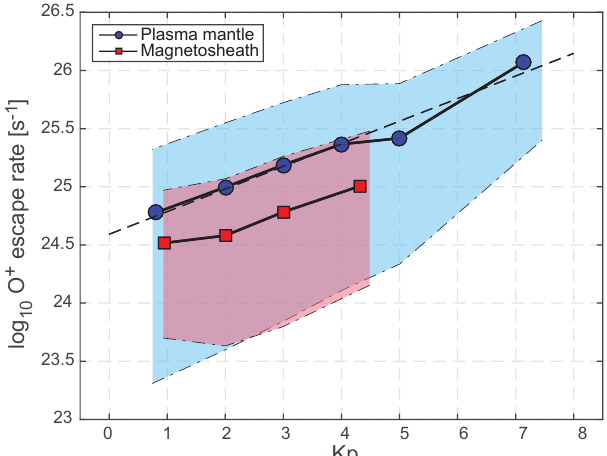
Figure 7. The average O + escape rates for the plasma mantle (solid blue line and circles) and the dayside magnetosheath (solid red line and squares) as a function of Kp. The dashed black line is a least- squares fit to the average escape rates for the plasma mantle. The thin dot-dashed lines correspond to estimated upper and lower O + escape rates in the plasma mantle (blue area) and the magnetosheath (red) based on the highest and lowest flux values observed under the different geomagnetic